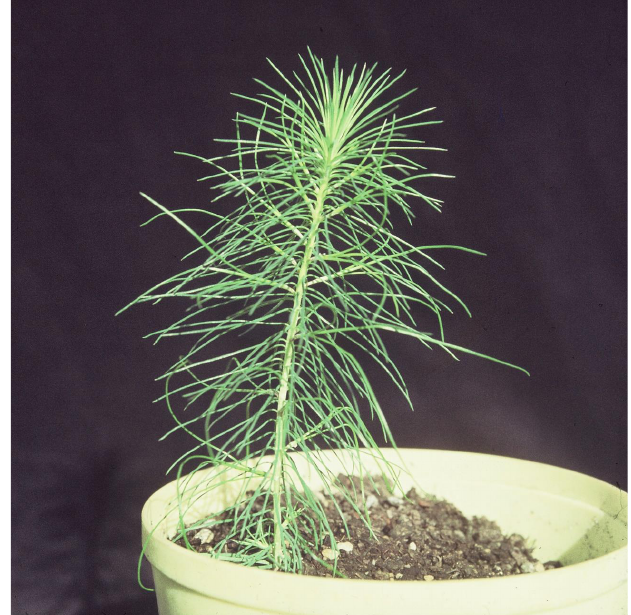
Figure 3. Young seedling of P. radiata , showing green apical tuft and a predominance of primary foliage in a neutral phenological state typical of Pinaceae (Scion Image Library). As the tree becomes older and larger, brown, scarious cataphylls eventually come to be produced in place of the green primary foliage. Long before this process is completed, however, fascicles (or bundles) of secondary foliage start to get produced in the axils of primary leaves or cataphylls. Eventually, a transition from producing green apical tufts to brown sealed buds is completed (Figures 4 and 5).